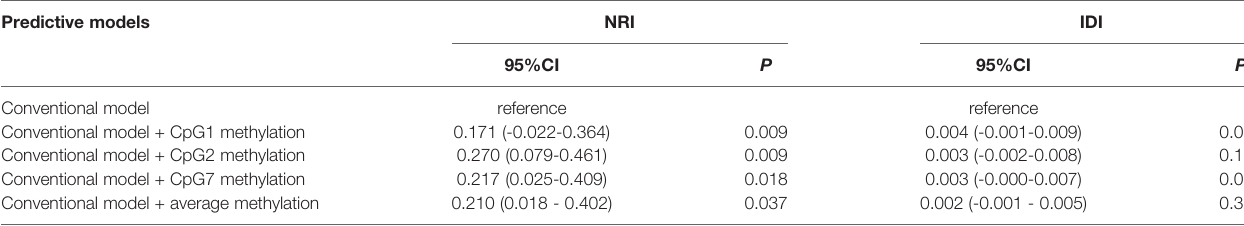
TABLE 3 | Reclassi fi cation and discrimination statistics for diabetes risk prediction by FURIN promoter methylation. Predictive models